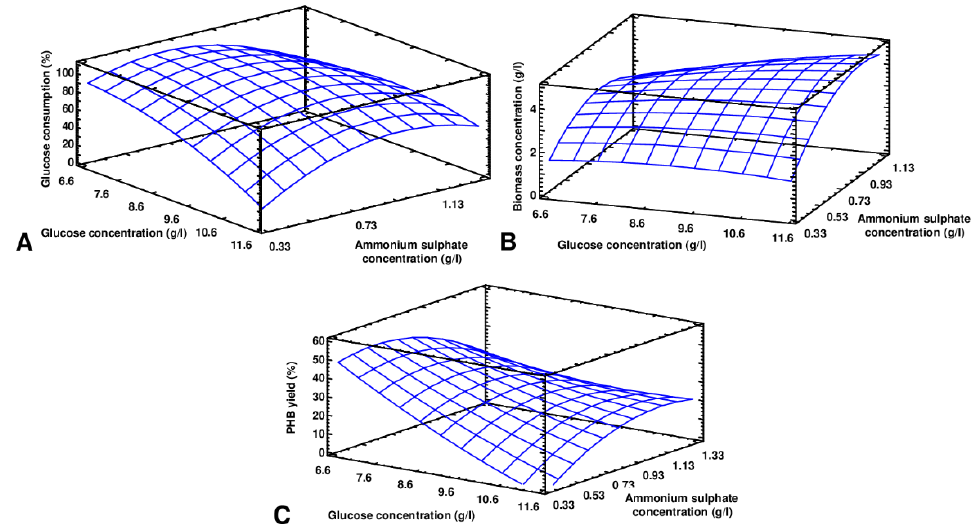
Figure 2. Graphs showing the effect of glucose and ammonium sulfate concentration on glucose consumption ( A ), biomass concentration ( B ), and PHB yield ( C ). The optimal value of phosphate buffer molarity was set as a constant.